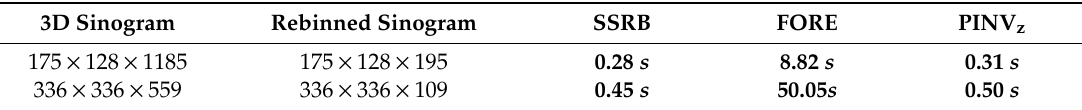
Table 4. Central Processing Unit (CPU) time for the different 2D reconstruction methods using a